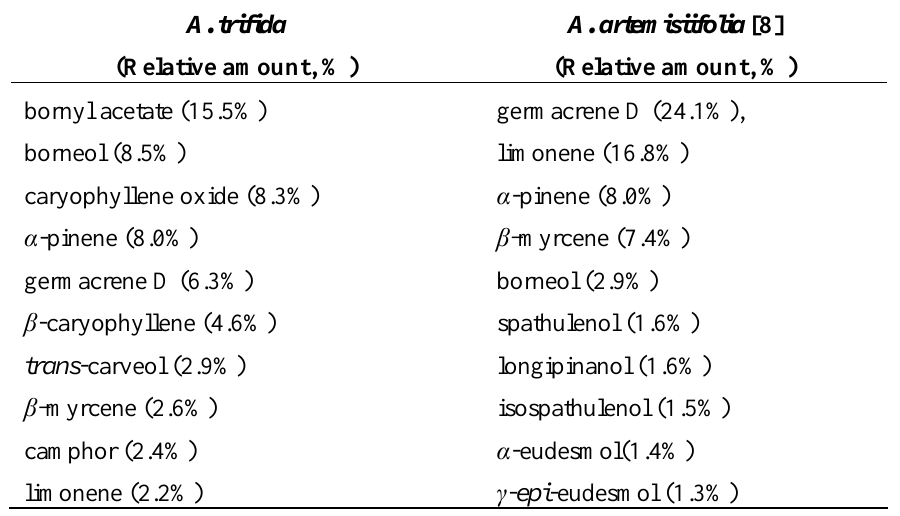
Table 2. Main composition of the essential oils from A. trifida and A. artemisiifolia